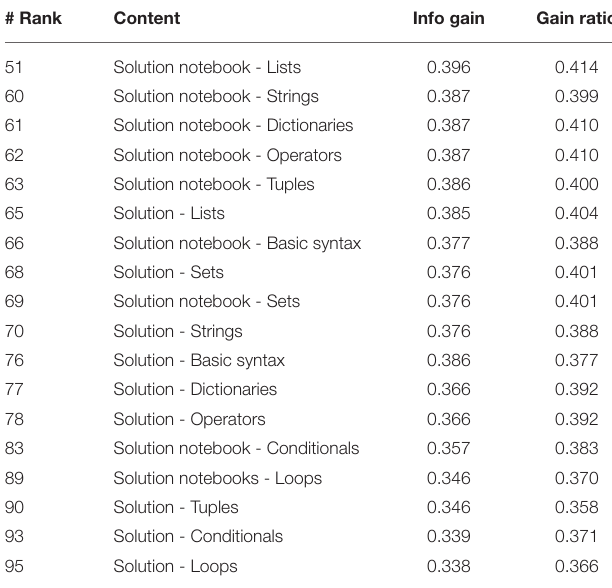
TABLE 7 | Solutions to the programming